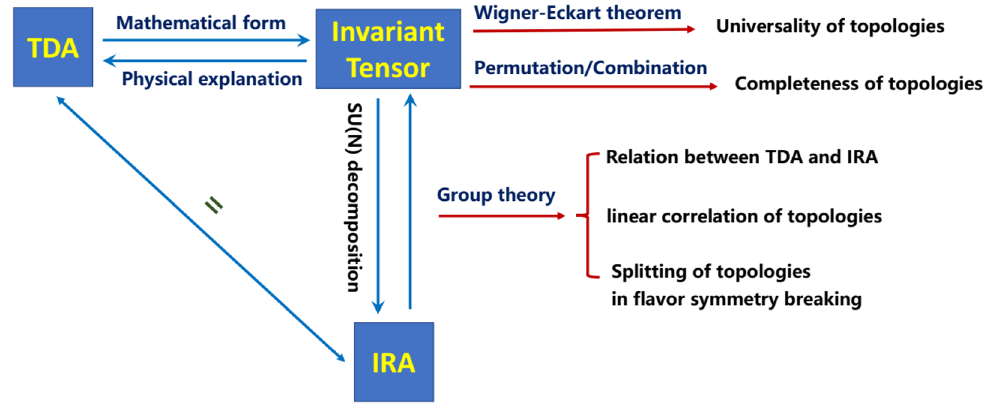
Figure 1 . Flow chart for the main point of topology in the tensor